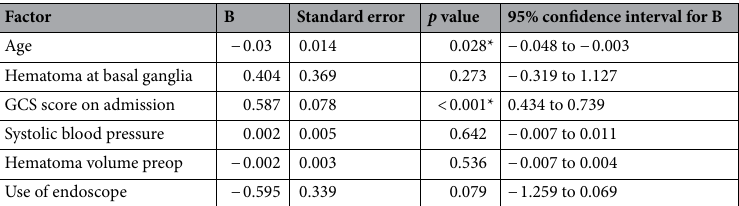
Table 3. Shift analysis using the ordinal logistic regression analysis for factors associated with the GCS score on day seven. Ordinal logistic regression analysis was performed using, in addition to age, the factors selected by univariate analysis with values of p < 0.10 and |r|> 0.20; hematoma at basal ganglia, GCS score and systolic blood pressure on admission, preoperative hematoma volume, and the use of the endoscope. B, coefficient; GCS, Glasgow Coma Scale. * p < 0.05 by ordinal logistic regression analysis.